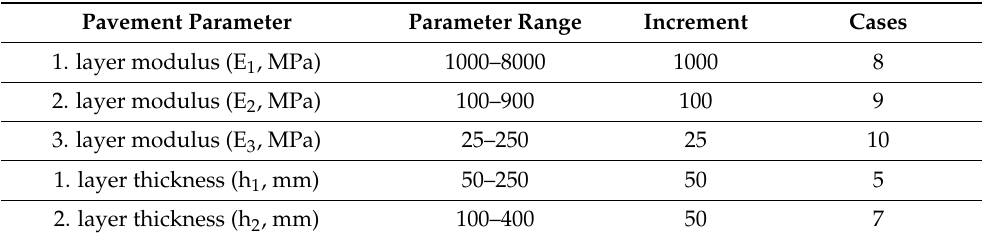
Figure 10. Layered elastic pavement model. Table 1. Variable parameters of pavement structure used in deflection analysis.